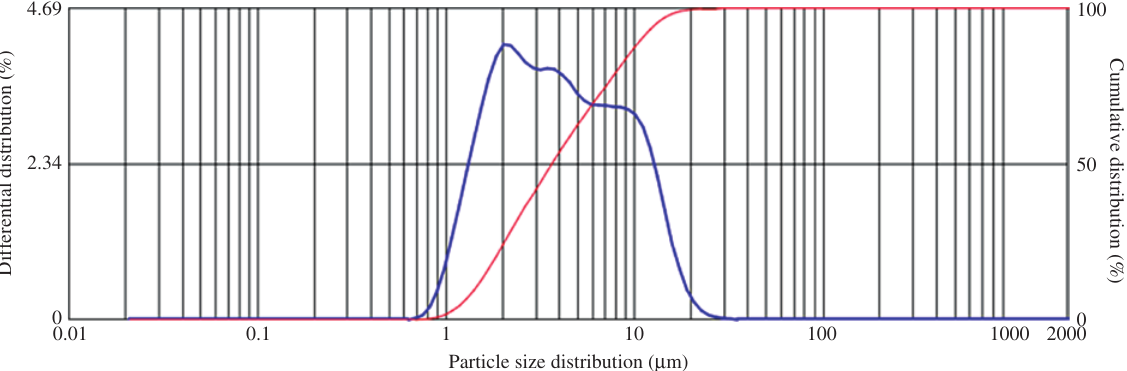
particles prepared under optimal experimental conditions by homogeneous precipitation 3